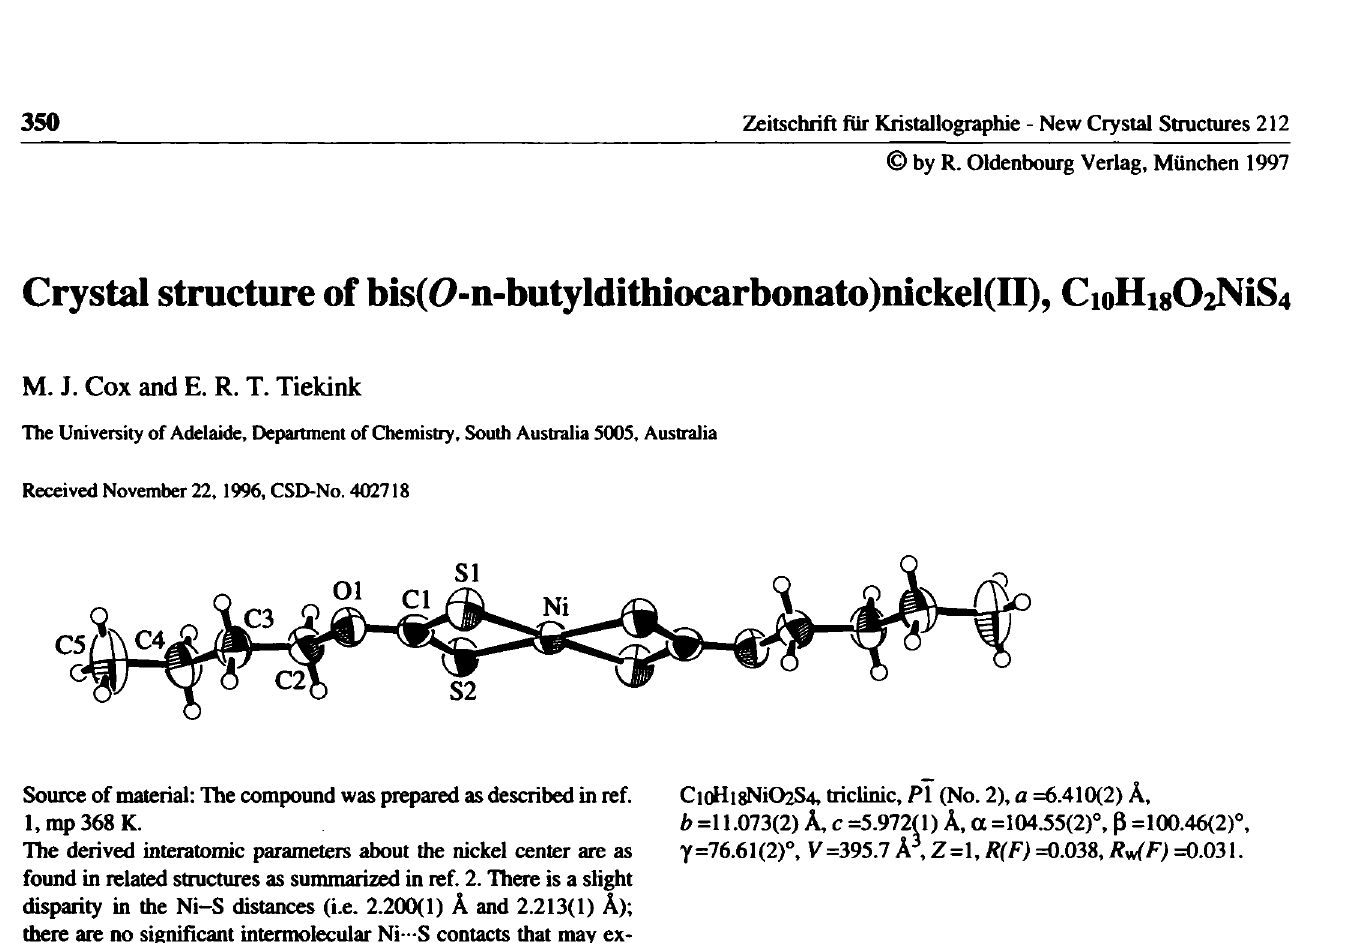
Table 1. Parameters used for the X-ray data collection TaWe 2 - F,nal atomic coordinates and displacement parameters (in Â 2 )